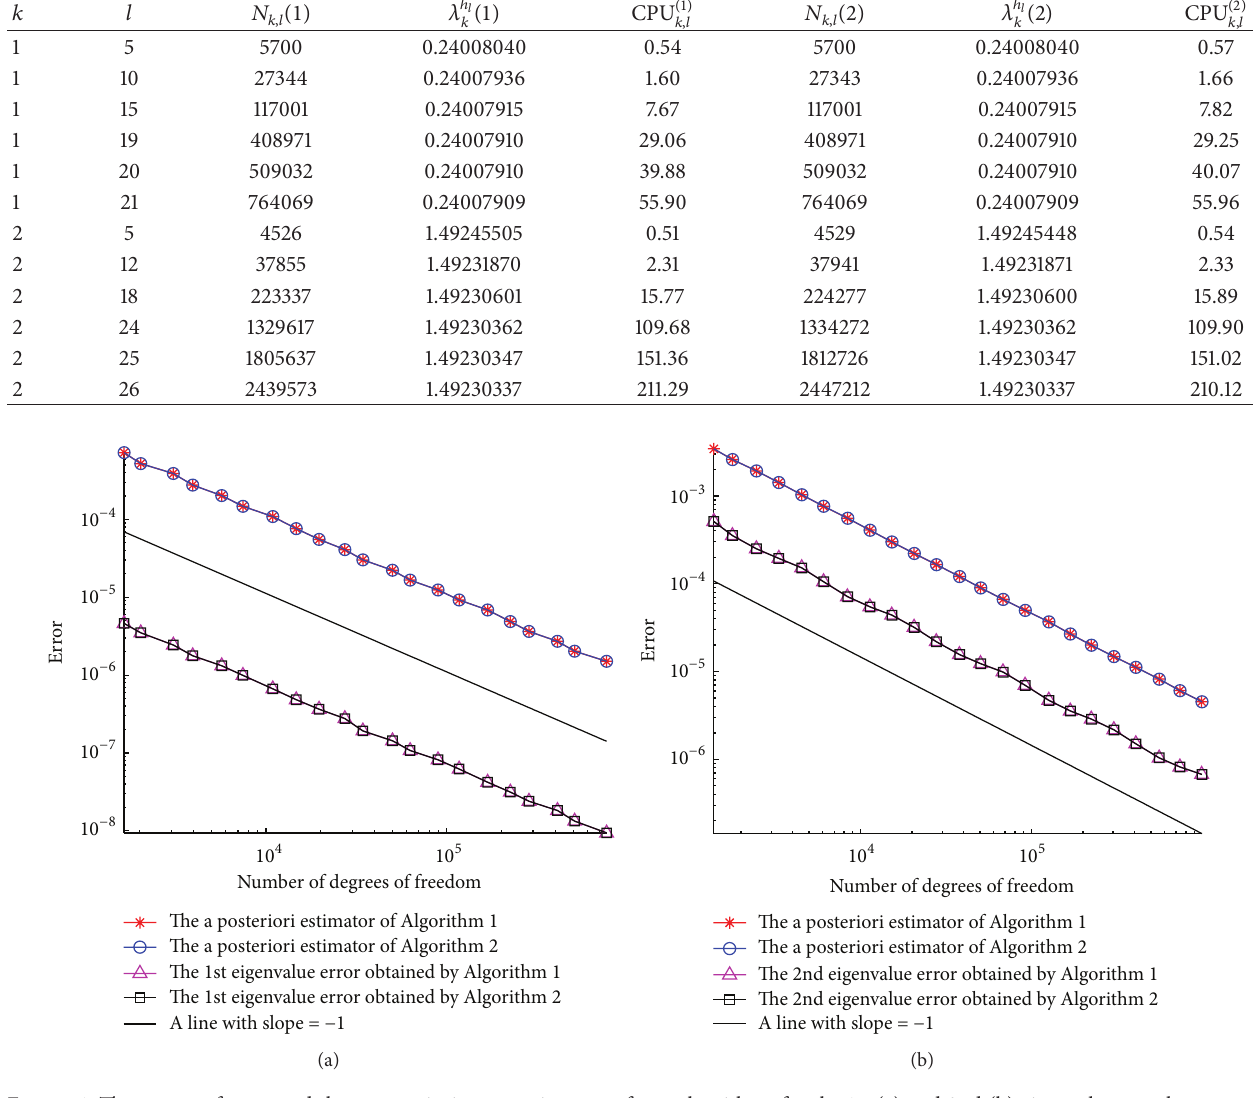
Figure 1: The curves of error and the a posteriori error estimators of two algorithms for the 1st (a) and 2nd (b) eigenvalues on the square